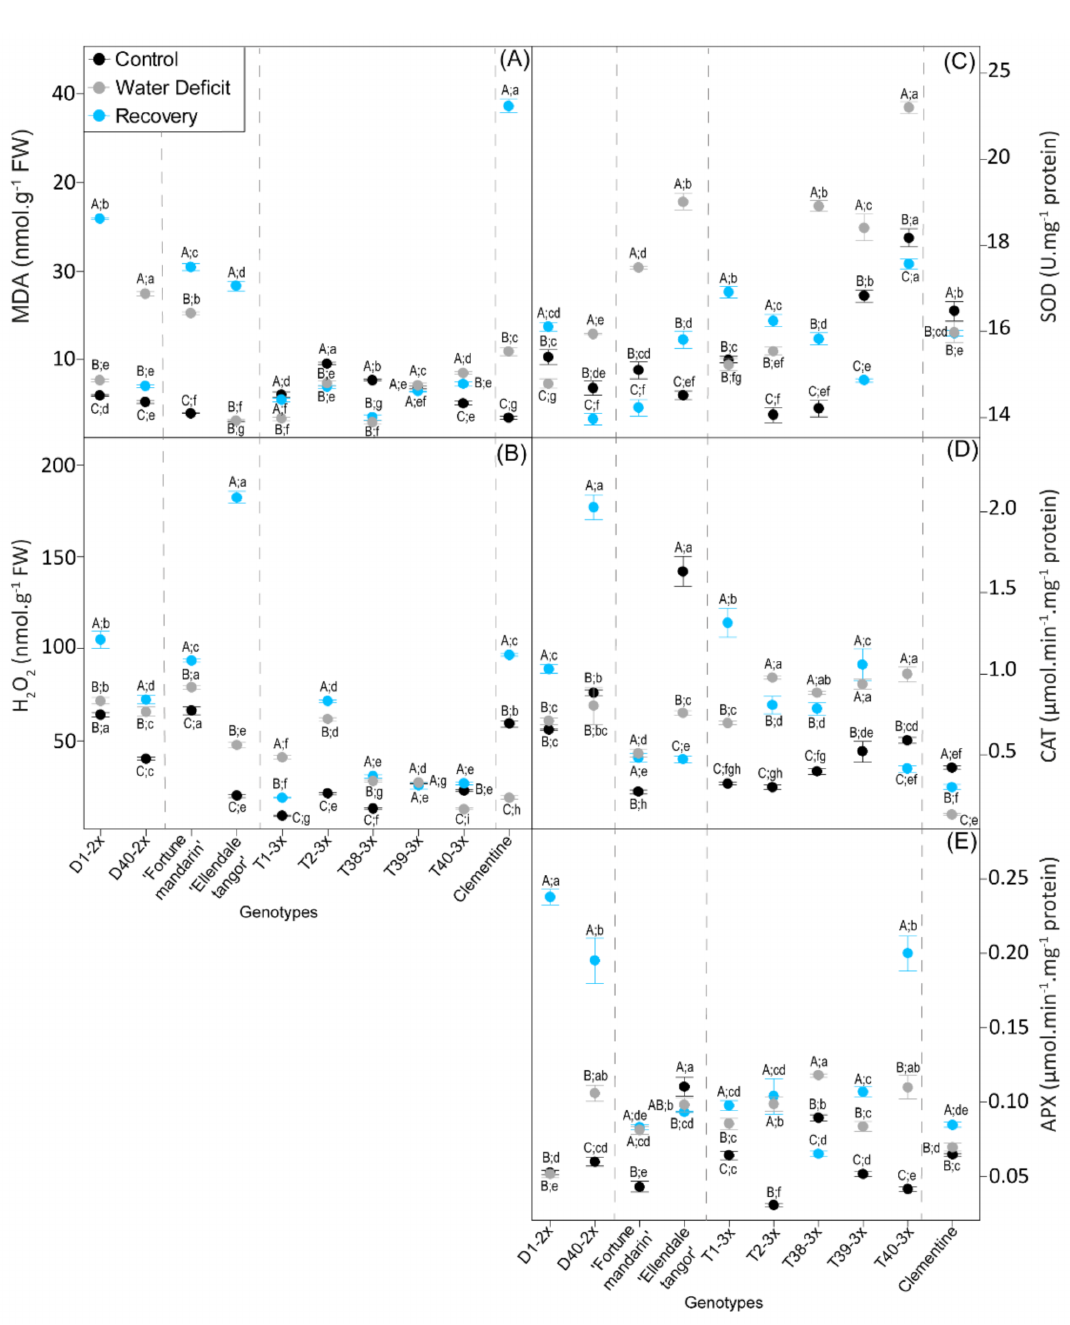
Figure 3. Oxidative stress markers and antioxidant enzymes in 2x and 3x genotypes under three water treatments: 70–100% pot capacity (black point, control), 45–55% pot capacity (grey points, water deficit), and five days after re-watering (blue point, recovery). ( A ) Malondialdehyde (MDA); ( B ) H 2 O 2 content; ( C ) specific activities of SOD, ( D ) CAT, and ( E ) APX. All data are mean values ( ± S.E.) of 15 independent measurements ( n = 15). Data were analyzed with ANOVA and Fisher’s LSD test ( p < 0.05). Uppercase letters compare water treatments for each genotype. Lowercase letters compare genotype within the same water